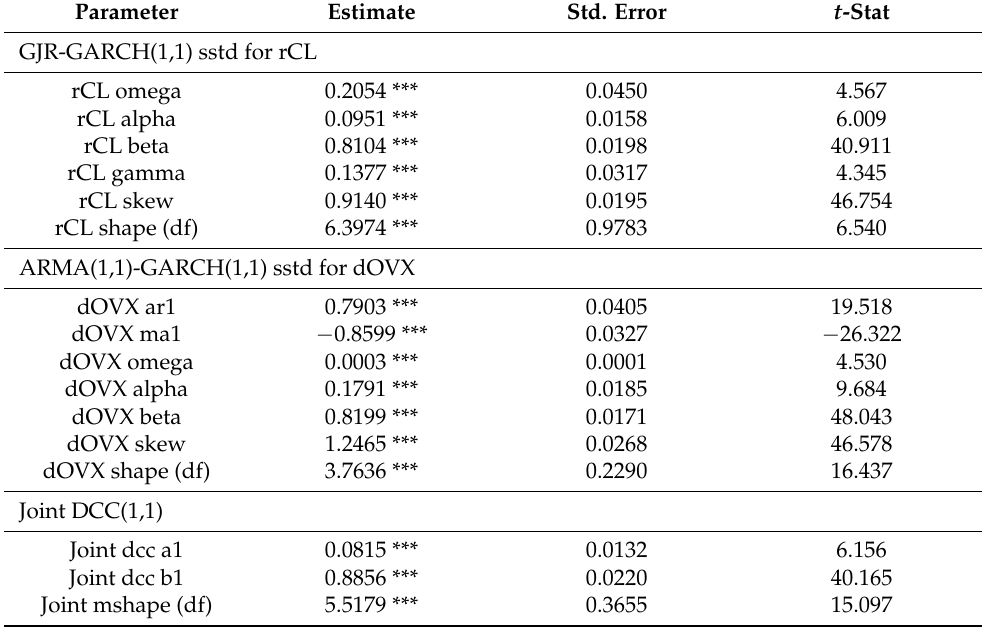
Table 5. Estimation of the t -copula-GARCH model for Crude Oil Future Contract returns (rCL) and changes in the CBOE Crude Oil Volatility Index (dOVX) in the entire period.